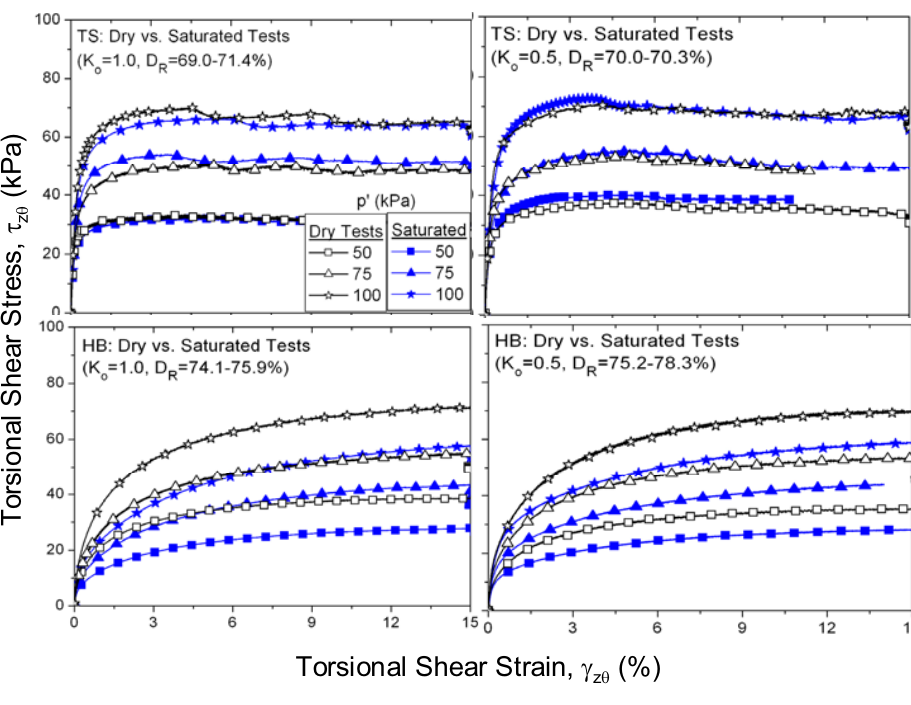
Fig. 12. CD monotonic torsional shear response of Toyoura sand and a typical crushed rock under saturated and dry conditions.